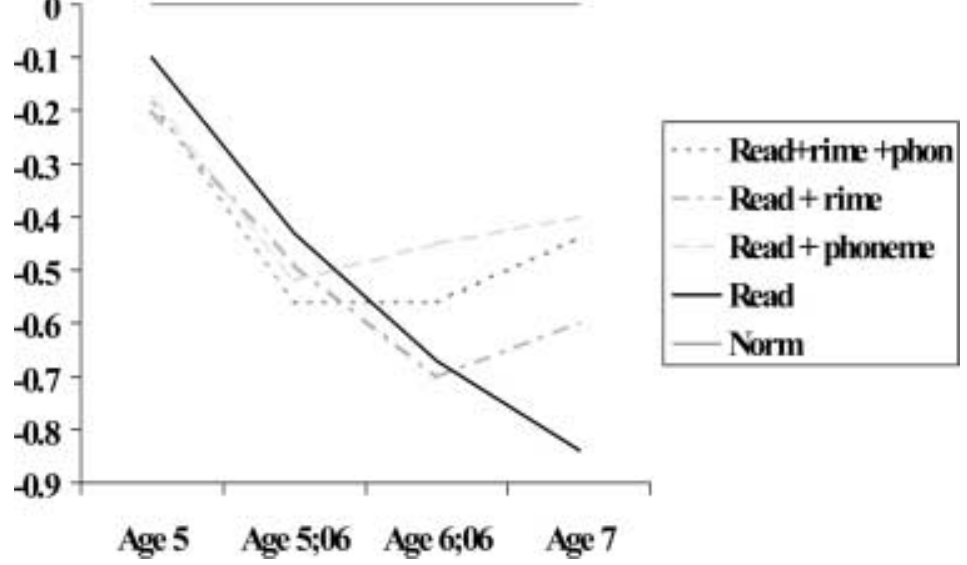
Figure 6. Reading attainments of children at risk of poor reading, relative to controls, during the first two years in school. The graph shows there is a widening gap between the skills of the ‘at risk’ group and their peers. However, the gap is shown as beginning to close in response to a phonic reading intervention supplemented by phonological awareness training (after Hatcher et al .,